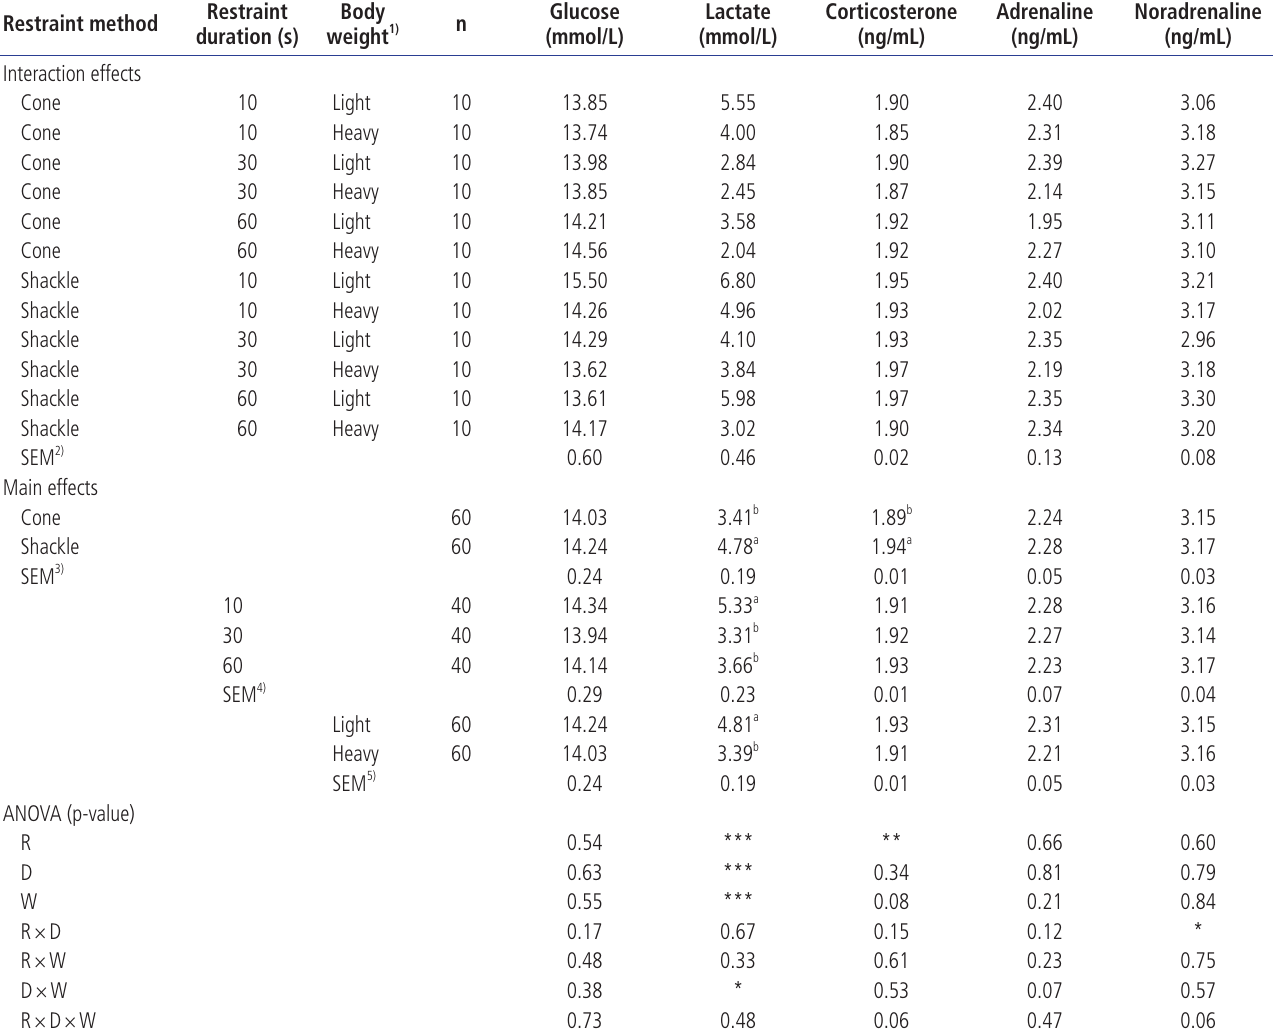
Table 1. Plasma metabolites and stress-linked hormones as affected by restraint method (R), duration of restraint (D), and body weight (W) prior slaughter in broiler chickens Restraint